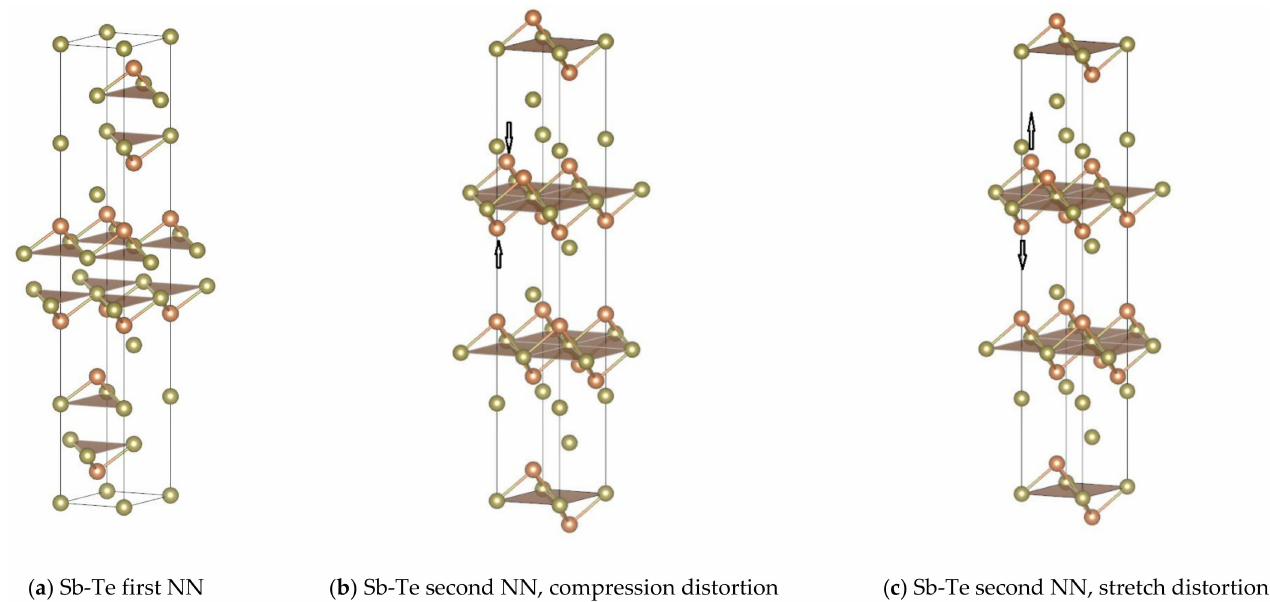
Figure 6. The first and second NN Sb-Te interactions shown in conventional hexagonal cell with polyhedral view: ( a ) first NN, ( b ) second NN, compression distortion, and ( c ) second NN, stretch distortion with